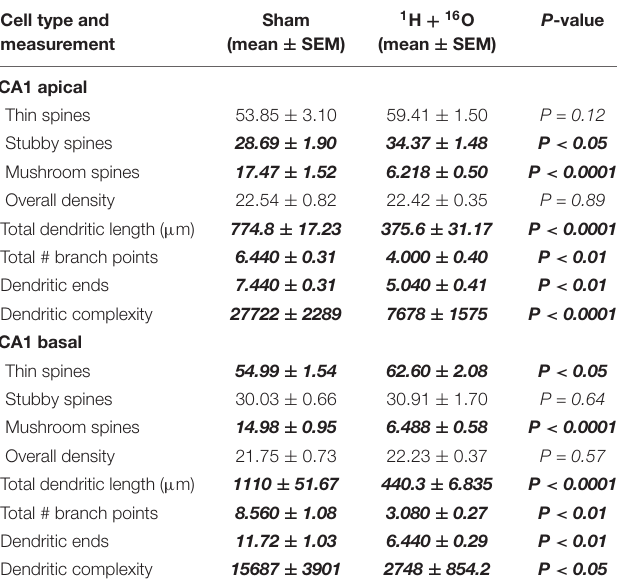
TABLE 2 | Effects of 1 H + 16 O irradiation on dendrite morphology in the